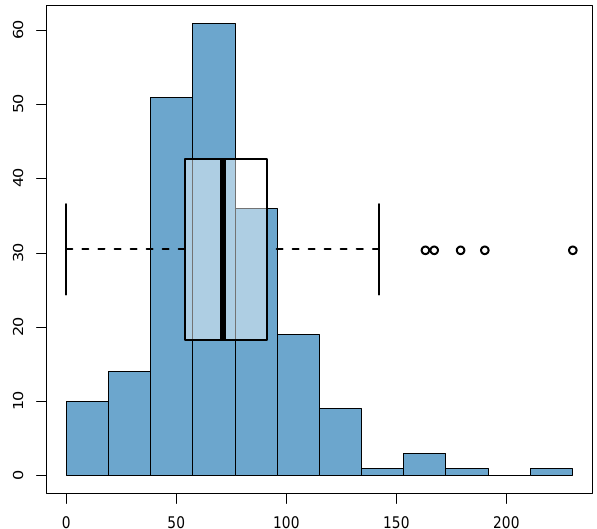
Figure 6. Boxplot and histogram of the durations of substance preparation. Axis X : durations of substance preparation in minutes. Axis Y : number of